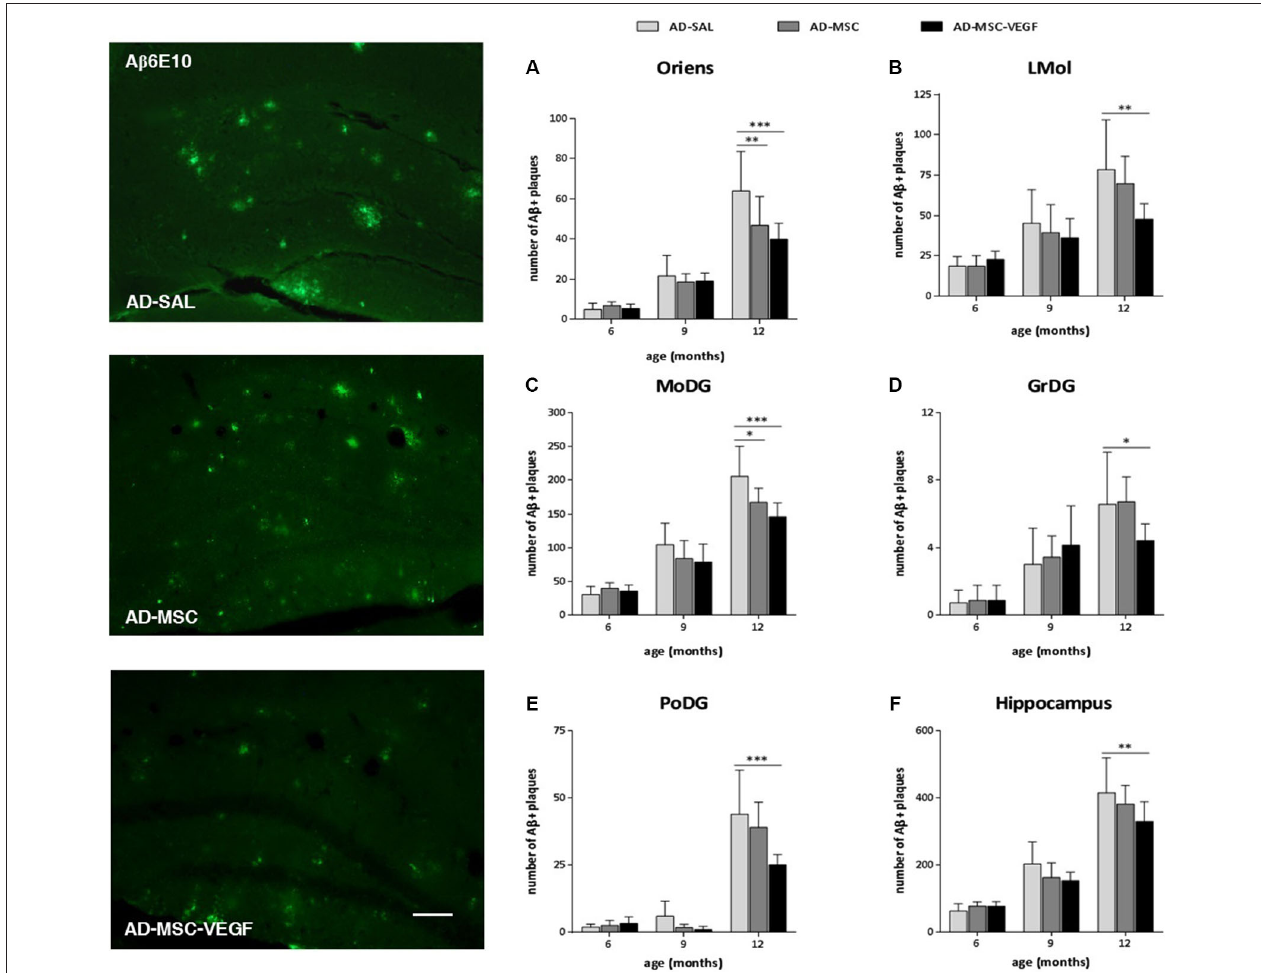
lacunosum molecular (LMol), (C) molecular (MoDG), (D) granular (GrDG) and (E) polymorphic (PoDG) layers and (F) in the whole hippocampus of the AD-SAL, AD-MSC and AD-MSC-VEGF transgenic animals at 6, 9 and 12 months (two-way ANOVA followed by Tukey’s multiple comparisons test, mean ± standard error; * P < 0.05; ** P < 0.01; *** P < 0.001, n = 7 per